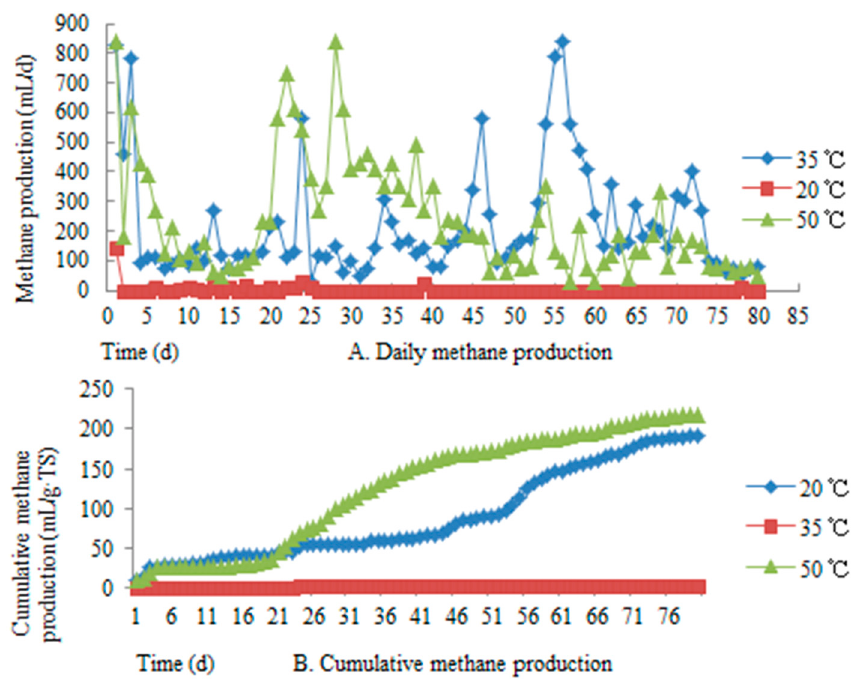
Figure 3. The change in methane production at different temperatures.